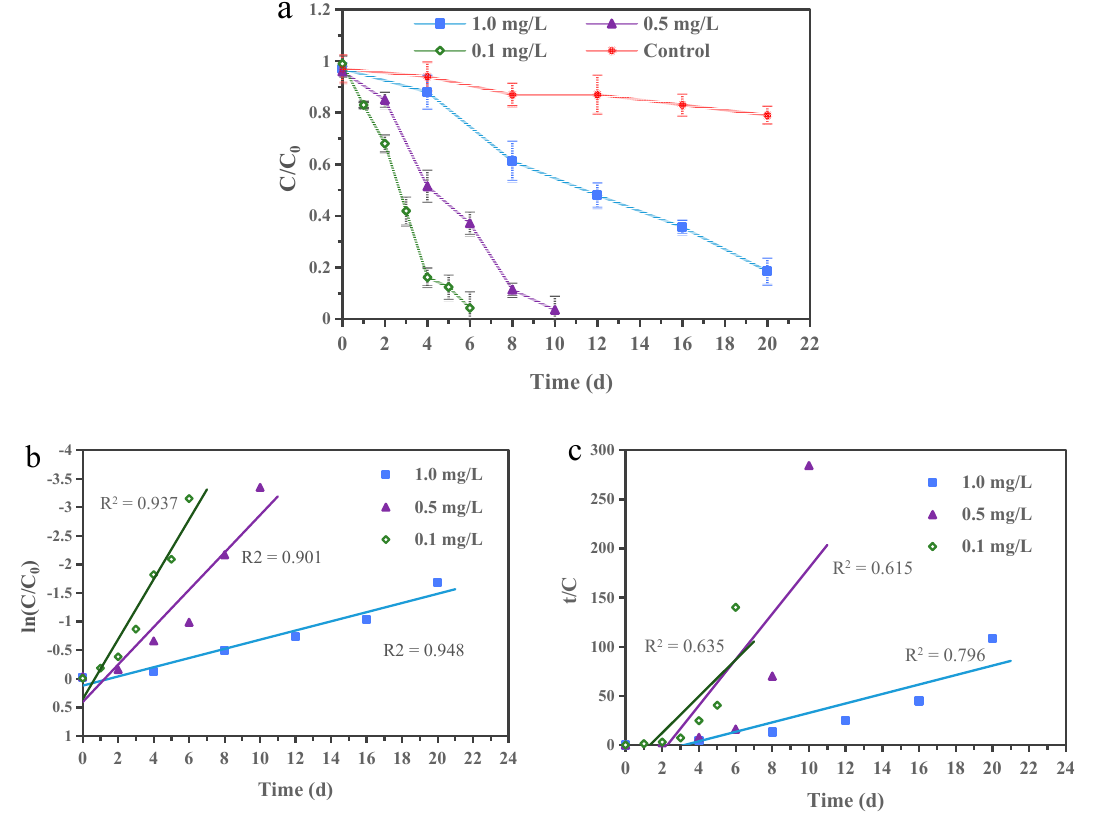
Figure 2. ( a ) EDB biodegradation kinetics and ( b ) its kinetic fittings by the pseudo-first-order, ( c ) pseudo-second-order in microcosms at 15 °C.